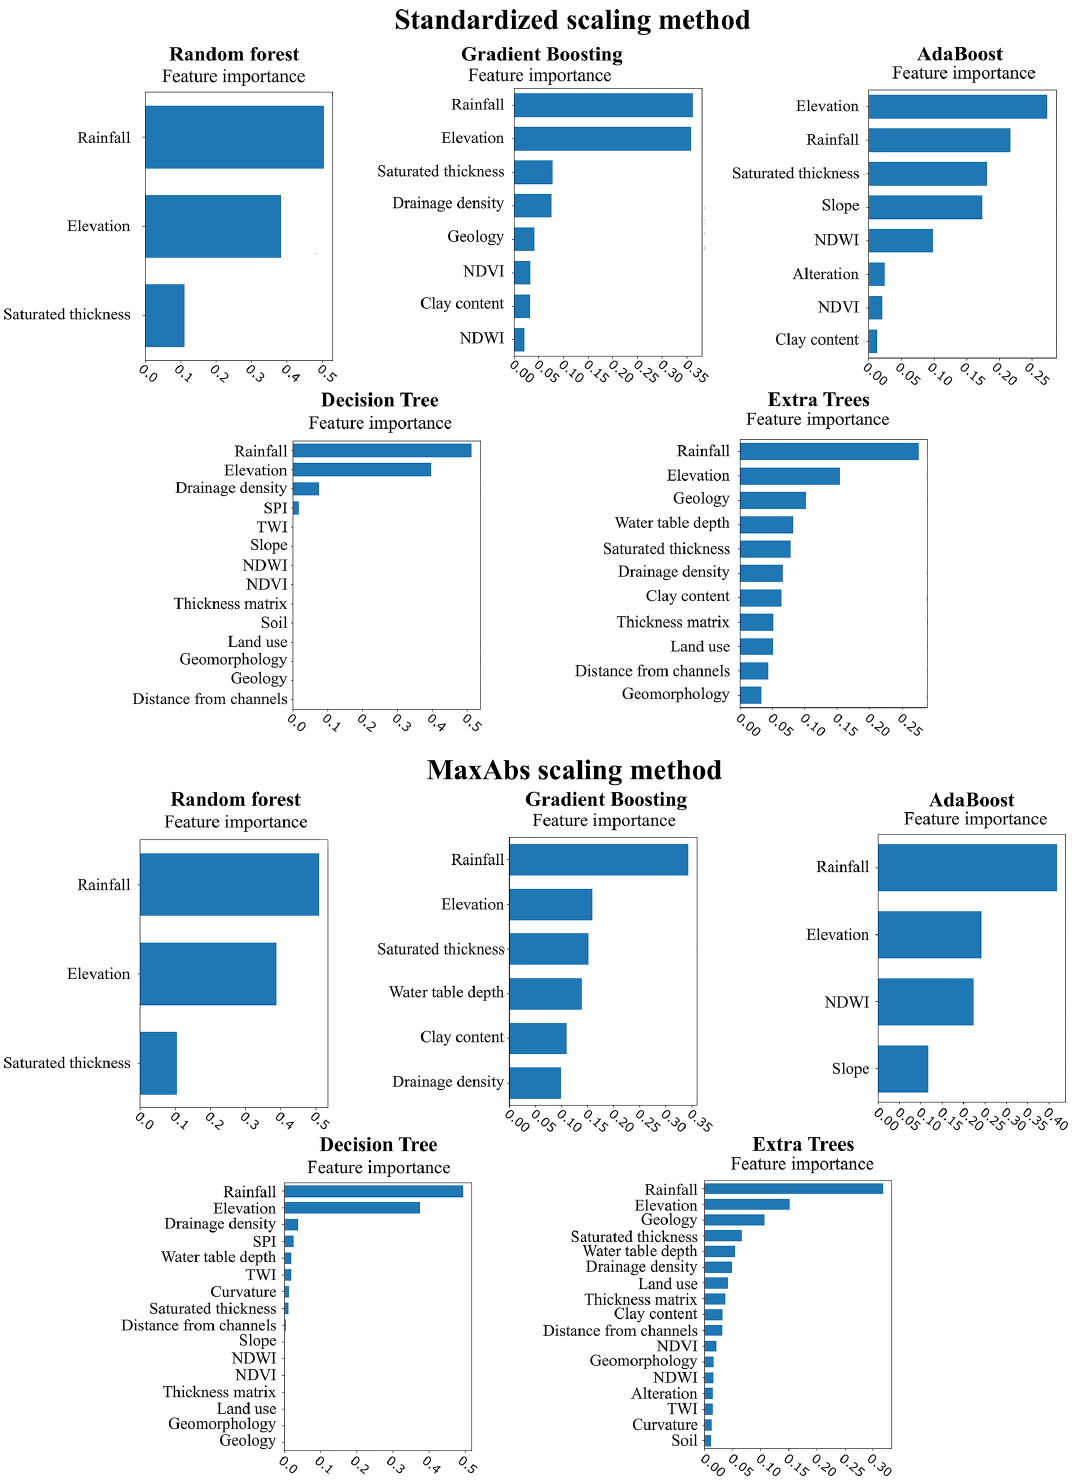
Figure 9. Feature importance calculated for the best-performing tree-based algorithms using the standardized and MaxAbs scaling methods. The sum of all variable weights equals